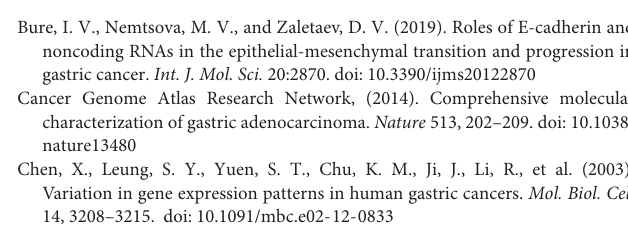
FIGURE S1 | Correlation between methylation status and expression of ISLR in gastric cases in the TCGA-STAD cohort. Detailed information on the methylation probe is provided. Pearson correlation coefficients (R) and Benjamini–Hochberg-adjusted P -values ( ∗ P < 0.05, ∗∗∗ P < 0.001) for the comparison are shown as well. FIGURE S2 | Correlation between the methylation status of ISLR DNA and the survival rate of gastric patients in the TCGA-STAD cohort. A total of eleven methylation probes, including cg15480336 (A) , cg03778780 (B) , cg02077702 (C) , cg20536146 (D) , cg11335960 (E) , cg24779381 (F) , cg05195566 (G) , cg177258195 (H) , cg09664357 (I) , cg07297039 (J) , and cg16926502 (K) , were used. FIGURE S3 | Correlation between ISLR and markers of T or B cells as analyzed through GEPIA2. (A) B cells; (B) Th1 cells; (C) Th2 cells; (D) Th17 cells; (E) CD8 + T cells; (F) Tfh cells; (G) resting Treg cells; (H) effector Treg cells; (I) exhausted T cells. FIGURE S4 | Correlation between ISLR CNV and the infiltration level of immune cells as analyzed through TIMER. (A) dendritic cells; (B) neutrophils; (C) CD8 + T cells; (D) CD4 + T cells; (E) B cells; (F) macrophages. ( ∗ P < 0.05, ∗∗ P < 0.01, ∗∗∗ P < 0.001). FIGURE S5 | GO_biological_process and GO_molecular_function enrichment analysis. The “clusterProfiler” R package was used for the GO_biological_process (A) and GO_molecular_function (B) enrichment analyses. FIGURE S6 | KEGG enrichment analysis. The “pathview” R package was used for the KEGG enrichment analysis. FIGURE S7 | GSEA. A LinkedOmics approach was utilized for the ISLR -correlated GSEA profiles. Four extracellular matrix (ECM)-associated gene sets, including genes involved in extracellular structural organization (A) , extracellular matrix structural constituents (B) , ECM-receptor interactions (C) , and miRNA targets in the ECM and membrane receptors (D) , were identified. FIGURE S8 | Correlation between ISLR expression and pathway activation or inhibition. FIGURE S9 | Correlation between ISLR expression and small molecule/drug sensitivity (IC50). TABLE S1 | Correlation of ISLR expression and the first progression status of gastric cancer patients in the GEO cohort (Kaplan–Meier plotter). TABLE S2 | Correlation of ISLR expression and the PPS of gastric cancer patients in the GEO cohort (Kaplan–Meier